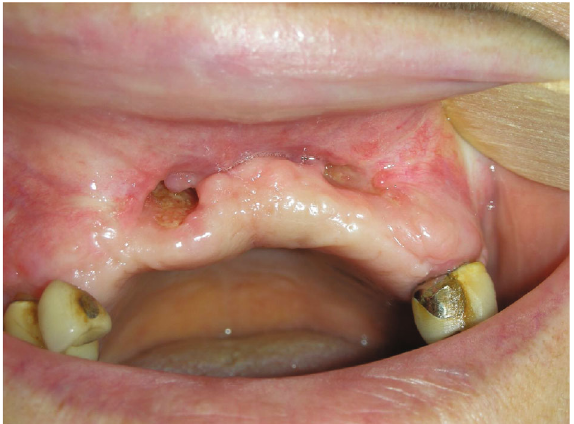
Figure 10: Postoperative dehiscence occurred after the removal of plates and screws, widely exposing the underlying equine graft.